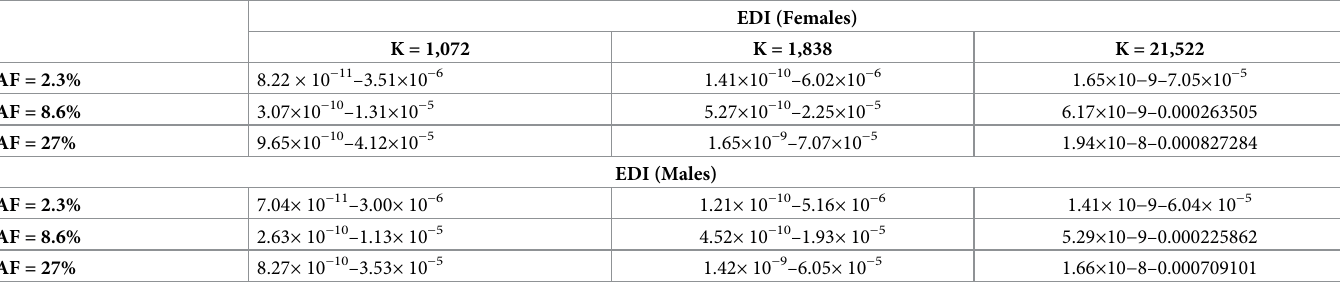
Table 3. EDI ( μ g/kg bw/day) range for general population (females and males) from “supermarket” thermal paper receipts under varying AF and k values.